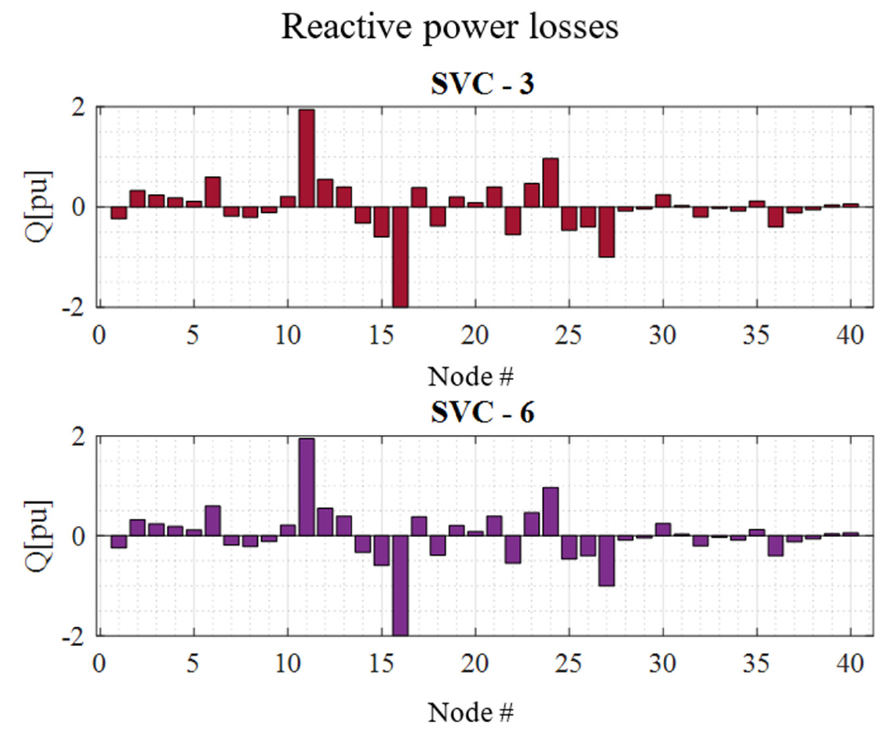
Figure 12. Profile of nodal reactive power for the IEEE 14-bus test system: SVC 3 and 6. IEEE 30-bus test system